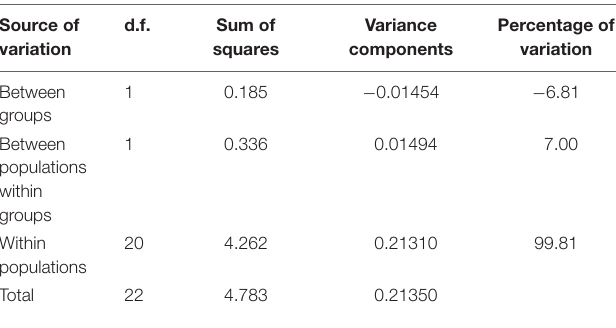
TABLE 1 | Analysis of molecular variance of three populations in the Red Sea. Group refers to the pooling of Jordan and Egypt together (northern population) and Farasan Banks alone (southern